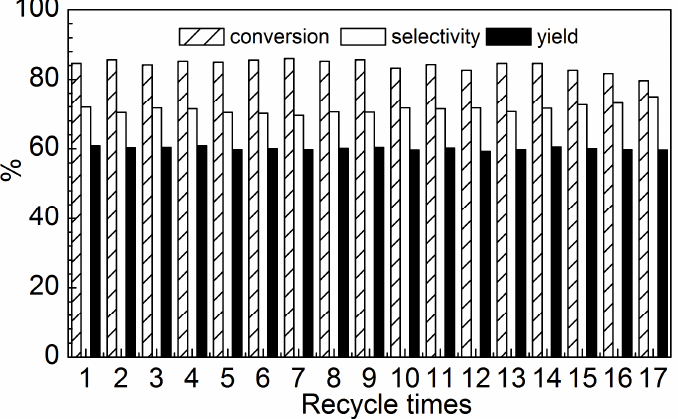
Figure 14. Reusability of Ru-Zn (0.60)/m-ZrO 2 for selective hydrogenation of benzene, including benzene conversion, cyclohexene selectivity, and yield (v H2O = 280 cm 3 , v benzene = 140 cm 3 , T = 423 K, p H2 = 5.0 MPa, t reaction = 40 min).